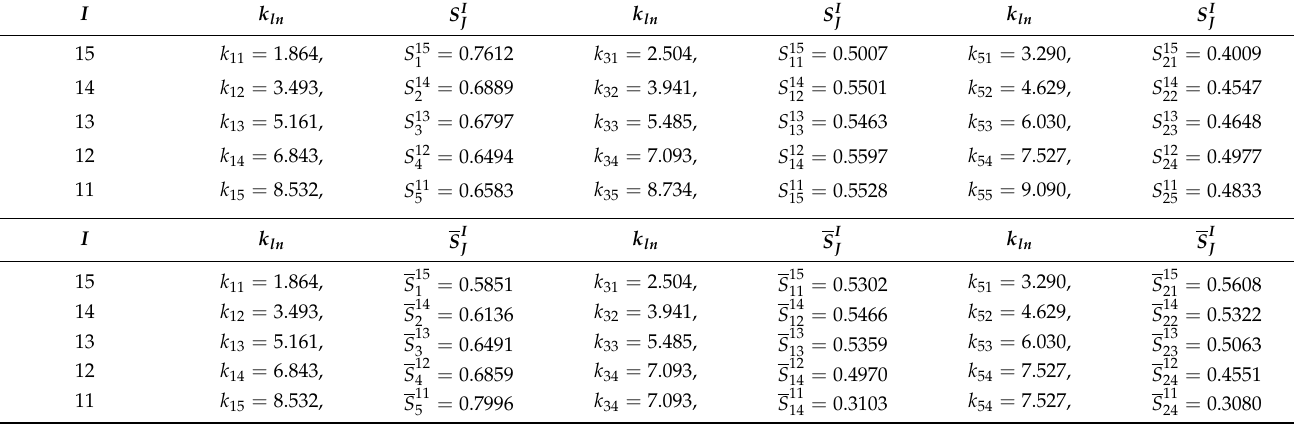
Table 3. First, to minimize confusion, remember that L = 5 and N = 5; second, I is just an arbitrary numbering of the L × N = 25 eigenmodes; third, J = N ( l − 1 ) + n , with 1 ≤ l ≤ L and 1 ≤ n ≤ N . For I = 11, · · · ,15 of Figures 1 and 5, this table has the values for the largest three S I I . These are the major matrix elements that define the (cid:60) ω with their associated wavenumbers k ln , which are drawn from Table